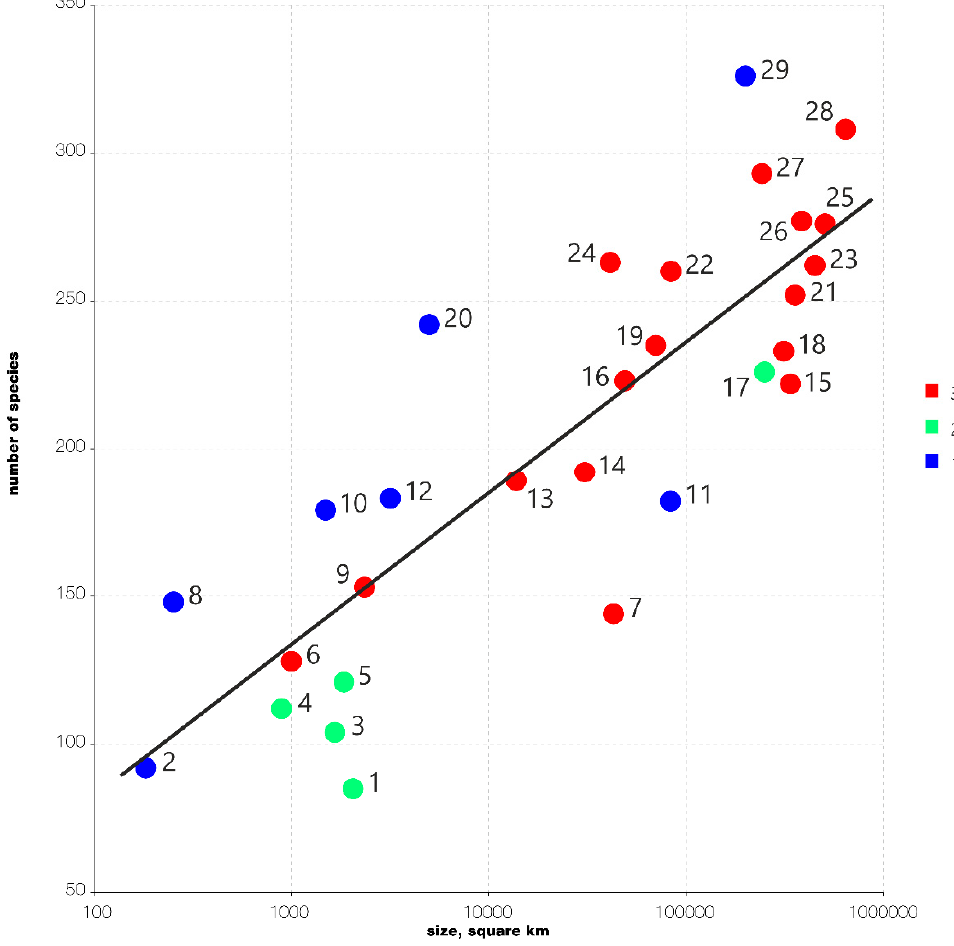
Figure 1. Species-area diagram based on data from Table 1. ( 1 ) Blue dots—hemiboreal and temperate floras in East Asia; ( 2 ) green dots—floras in hemiarctic Northeast Asia; ( 3 ) red dots—floras in Europe. Arrhenius SAR fitted for European floras. Table 1. The data on taxonomic diversity and area size in selected floras used for graphic diagram